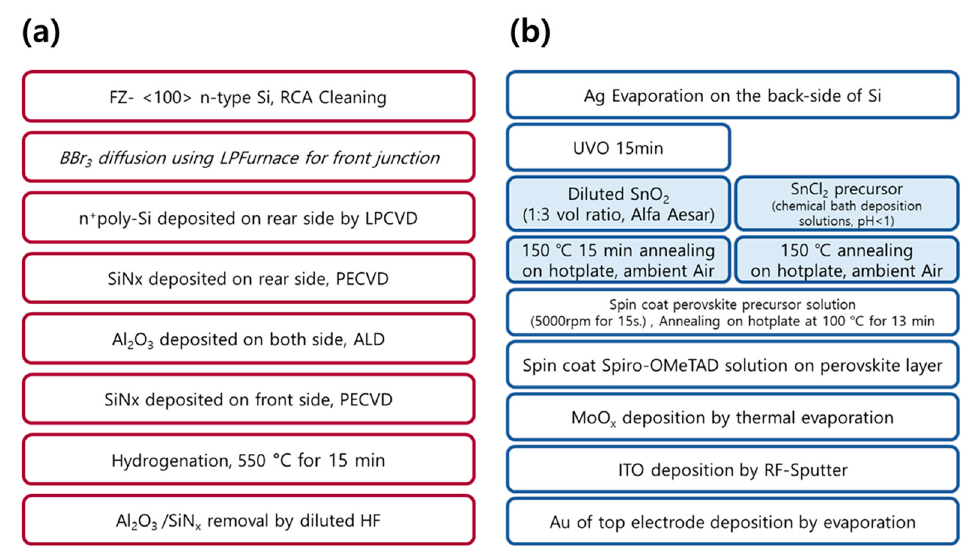
Figure 1. Experimental procedure for fabricating monolithic perovskite/silicon tandem solar cells. ( a ) Preparation of the silicon bottom cell and ( b ) perovskite top cell .